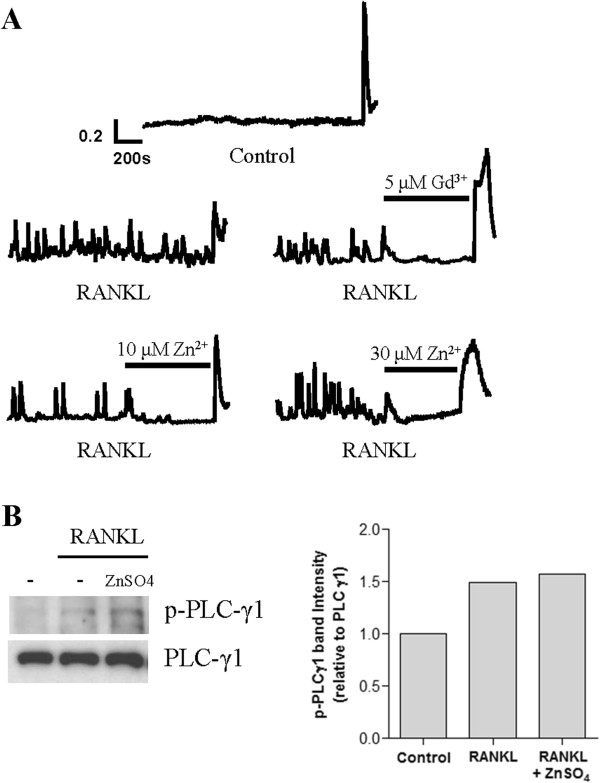
Zinc Suppresses RANKL-induced Ca2+ Oscillation in RAW264.7 cells without decreasing PLCγ1 activity. (A) RAW264.7 cells were cultured for 48 hours with RANKL (35 ng/ml) (n=3). Intracellular Ca2+ in single cells was measured using Fura-2/AM (5 μM). After observing RANKL-induced spontaneous Ca2+ oscillations for 10 minutes, ZnSO4 (10 or 30 μM) was added to the bath solution. At the end of the experiment, ionomycin (5 μM) was added. We used Gd3+, a known calcium channel blocker, as a positive control. Data shown represent one experiment of three performed with similar results. (B) RAW264.7 cells were stimulated for 30 minutes with RANKL (35 ng/ml) or RANKL (35 ng/ml) plus ZnSO4 (100 μM). Prepared proteins were analyzed by western blotting with anti-phospho-PLCγ1 or anti-PLCγ1 antibodies. Protein levels were quantified using densitometry.